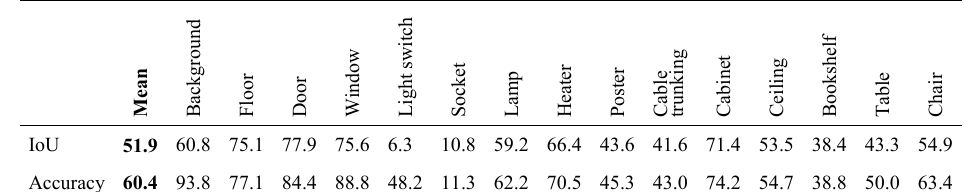
Table 2. Calculated intersection over union and accuracy of the objects present in the